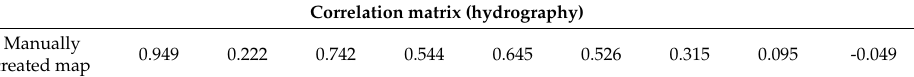
Table 10. Correlation matrices and basic statistic parameters for the 5000 m mesh control points grid.